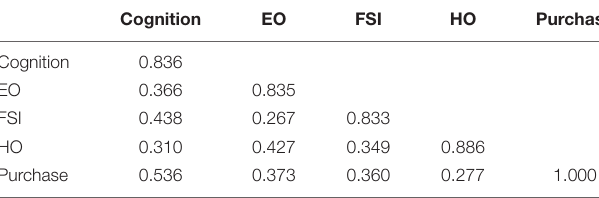
TABLE 5 | Fornell–Larcker criterion.